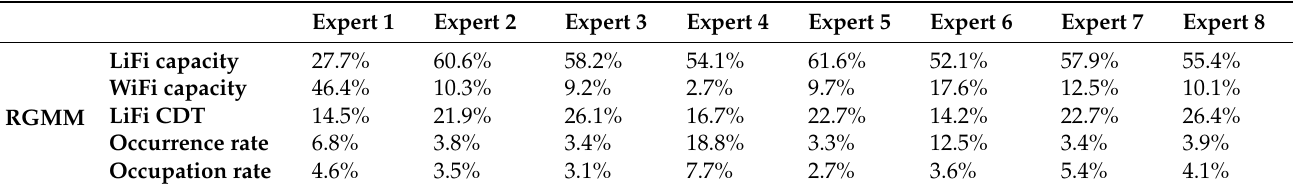
Table 17. RGMM for all the criteria by each